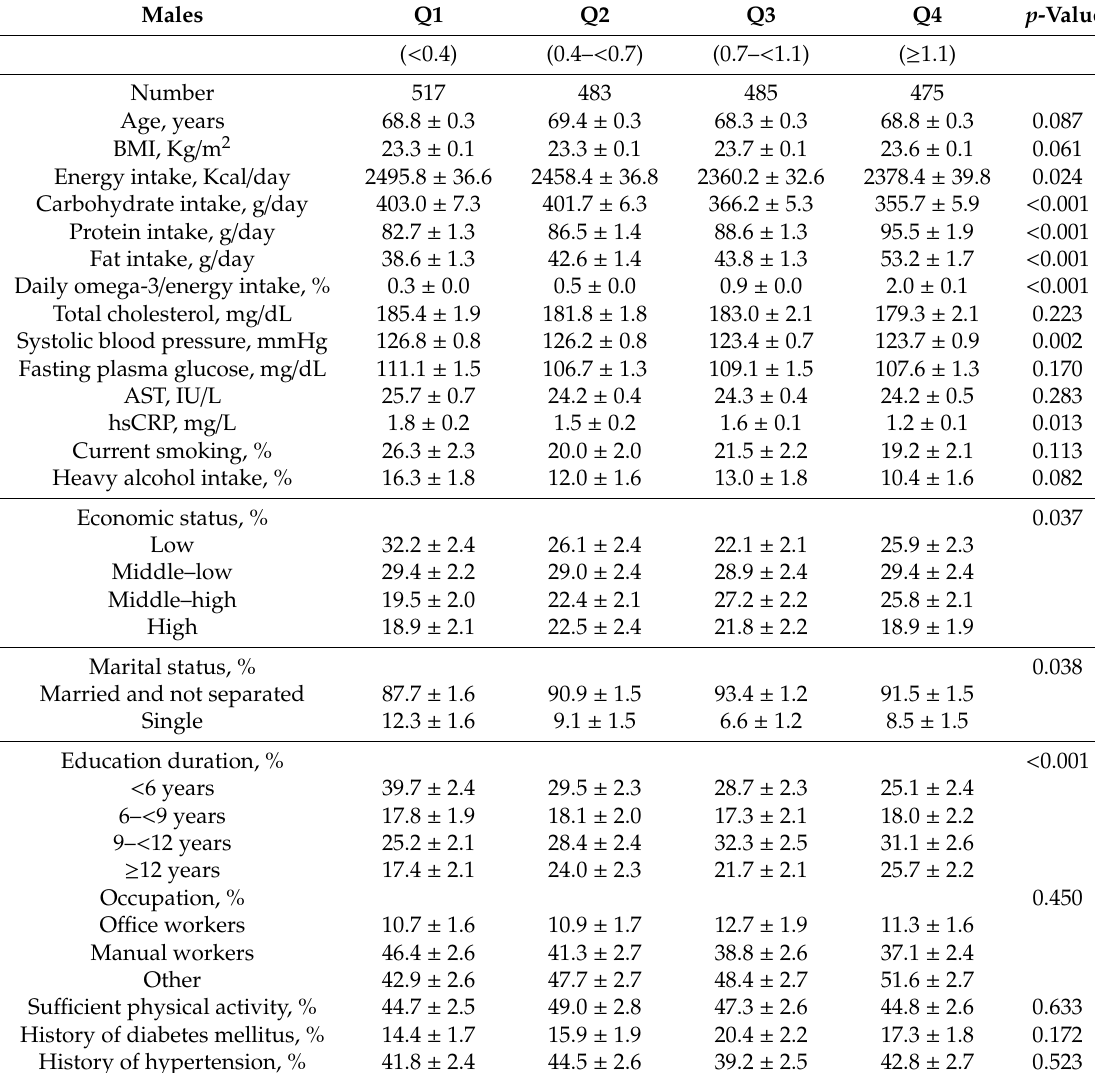
Table 2. Population characteristics according to quartiles of ω 3FA